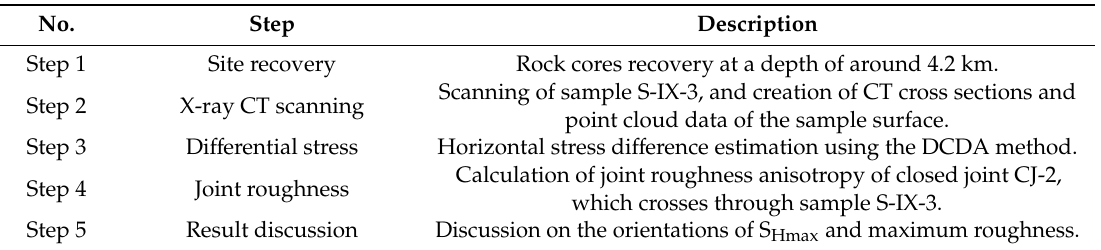
Table 1. Process followed to estimate stress difference and joint roughness for sample S-IX-3.